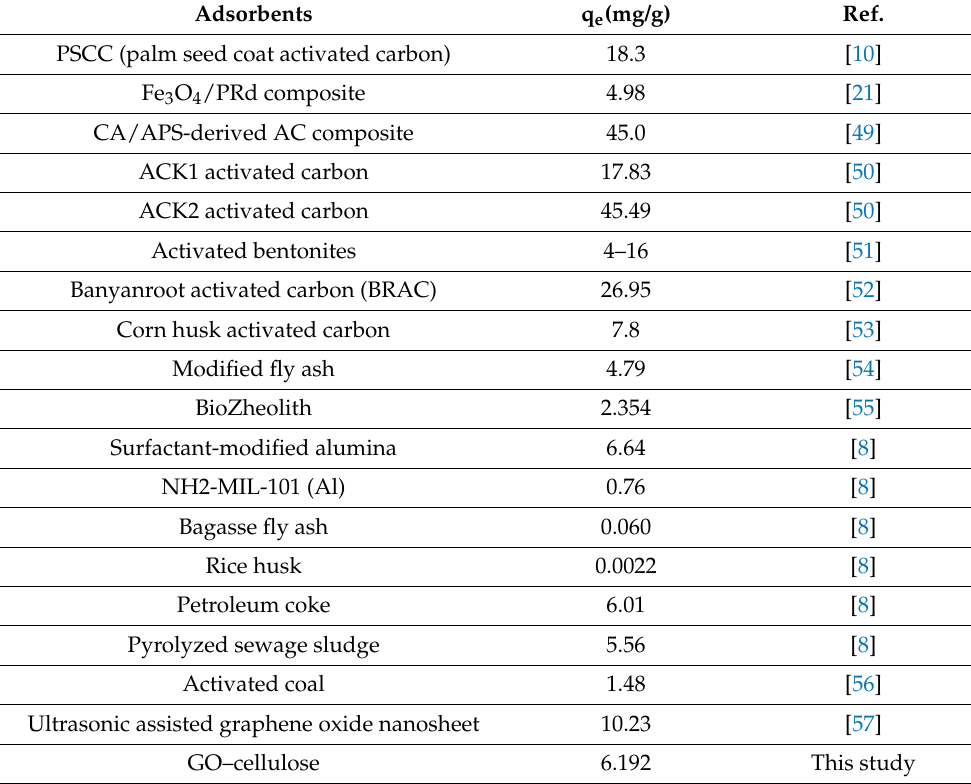
Table 4. A comparative study of the adsorption behavior of GO–cellulose composites and other adsorbents on